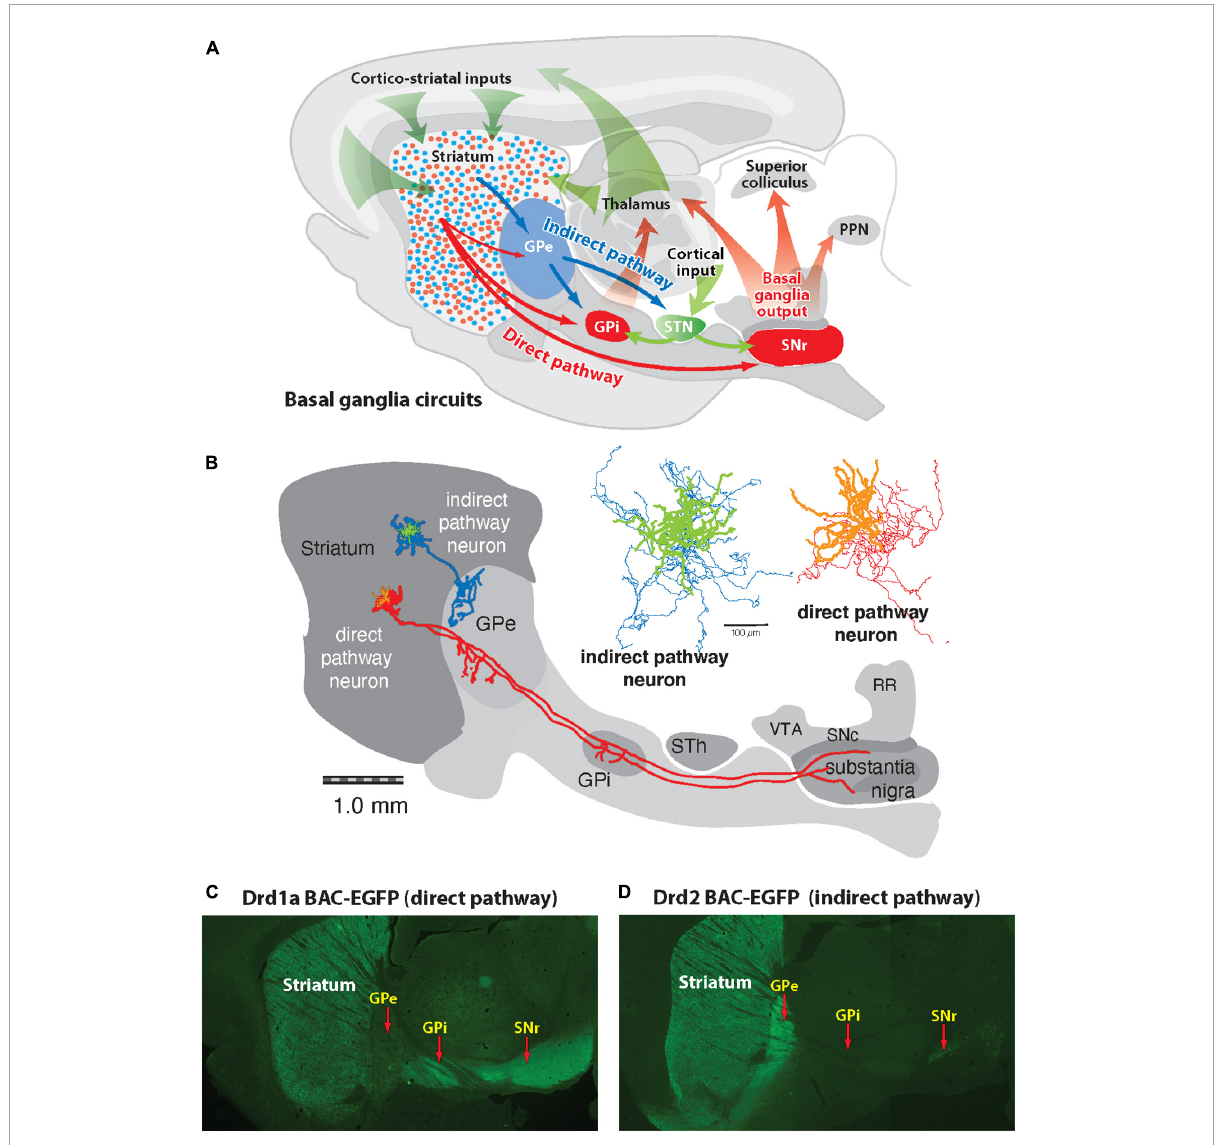
FIGURE1 Diagram of basic basal ganglia circuits. (A) The striatum receives excitatory corticostriatal and thalamic inputs. Outputs of the basal ganglia arise from the internal segment of the globus pallidus (GPi) and substantia nigra pars reticulata (SNr), which are directed to the thalamus, superior colliculus, and pedunculopontine nucleus (PPN). The direct pathway originates from Drd1a-expressing SPNs that project to the GPi and SNr output nuclei. The indirect pathway originates from Drd2-expressing SPNs that project only to the external segment of the globus pallidus (GPe), which together with the subthalamic nucleus (STN) contain transynaptic circuits connecting to the basal output nuclei. (B) Tracings of individual indirect and direct striatal projection neurons drawn in place on a sagittal brain diagram (Kawaguchi et al., 1989). The indirect striatal pathway neuron (green) has axon collaterals (blue) that spreads locally within the striatum and one that projects into the GPe, where it arborizes, and does not extend beyond this nucleus. The direct striatal pathway neuron (orange) has a local collateral within the striatum and projection axons (red) that extend some collaterals into the globus pallidus (GPe), and others to the globus pallidus internal segment (GPi) and substantia nigra. (C) Fluorescent imaging of a brain section from a mouse expressing enhanced green fluorescent protein (eGFP) under regulation of the Drd1a promoter shows Drd1a-expressing SPNs in the striatum that project axons through the GPe, which terminate in the GPi and GPe. (D) Fluorescent imaging of a Drd2-eGFP mouse shows that labeled SPNs provide axonal projections that terminate in the GPe but do not extend to the GPi or